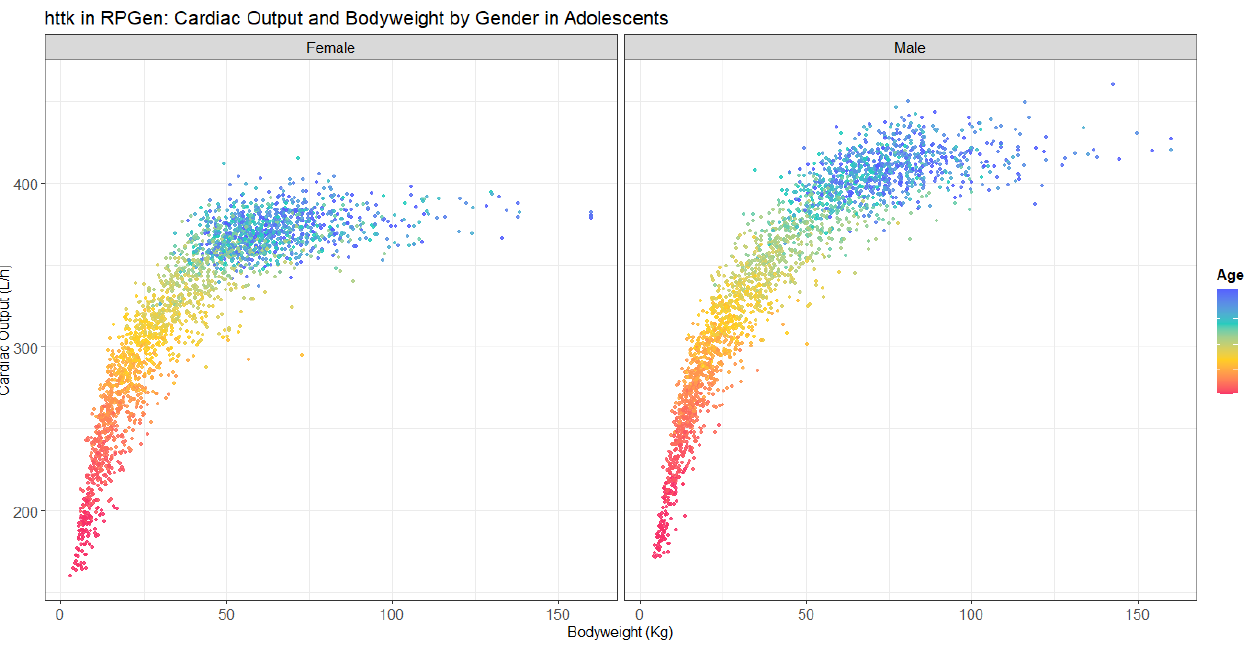
Figure 5. Adolescent (21 and under) cardiac output in males and females, n =